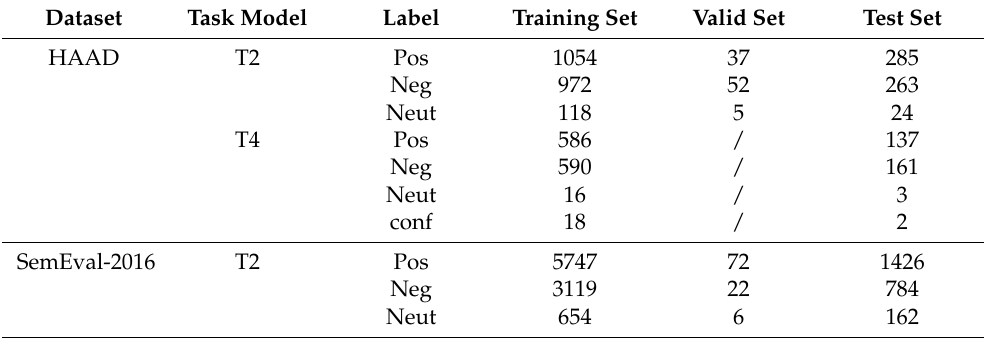
Table 5. Our sample distribution for HAAD and SemEval-2016 datasets with T2 and T4 models. Pos refers to positive, Neg (negative), Neut (neutral), and conf (conflict). Dataset Task Model Label Training Set Valid Set Test Set HAAD T2 Pos 1054 37 285 Neg 972 52 263 Neut 118 5 24 T4 Pos 586 / 137 Neg 590 / 161 Neut 16 / 3 conf 18 / 2 SemEval-2016 T2 Pos